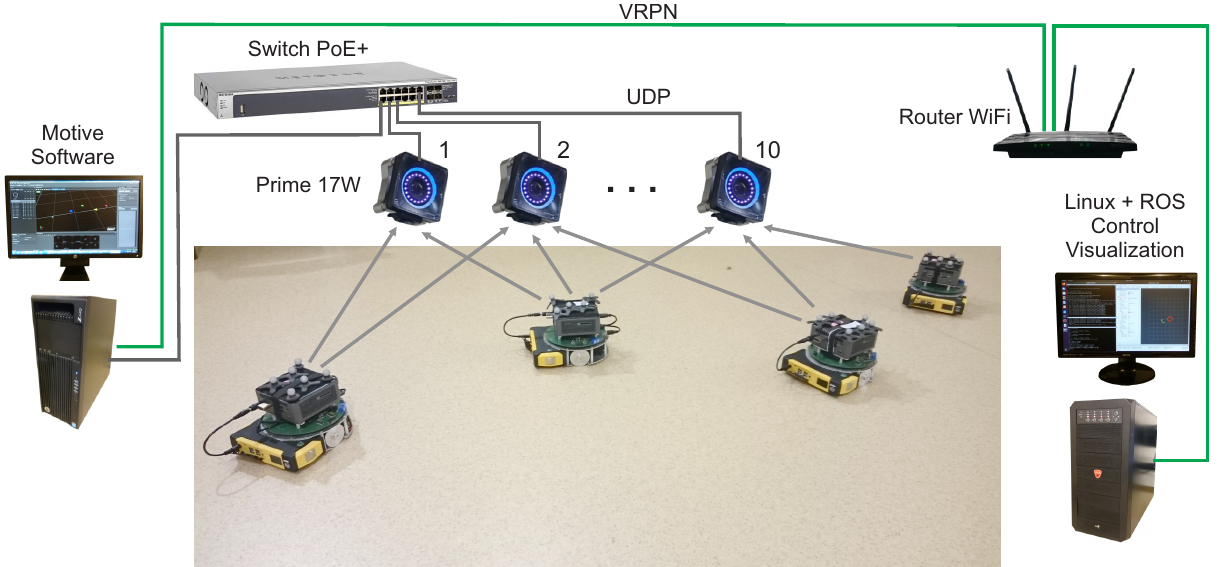
Figure 3. Experimental setup general